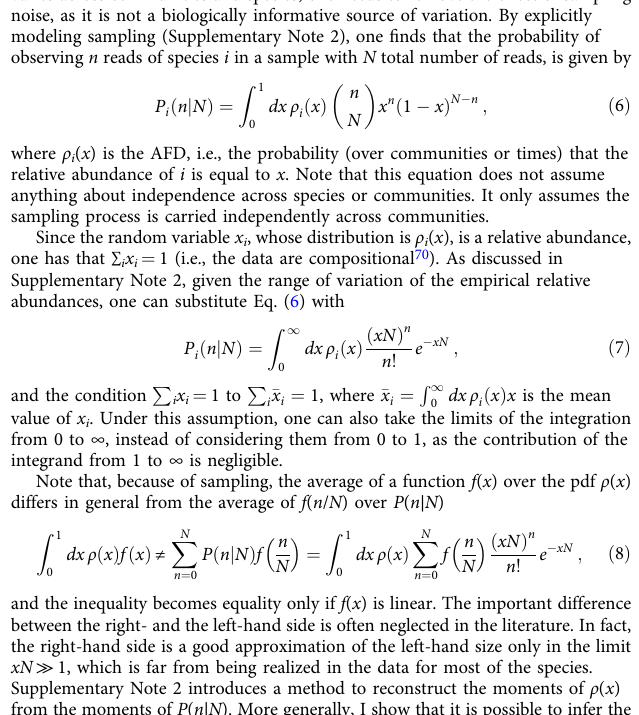
Table 1) report the original experiments and corresponding analysis. In order to test the robustness of the macroecological laws and the modeling framework presented in this work, we considered 7 data sets that differ not only for the biome considered, but also for the sequencing techniques and the pipeline used to process the data. Data sets were selected to represent a wide set of biomes. We considered only data sets with at least 50 samples with more than 10 4 reads. No data set was excluded